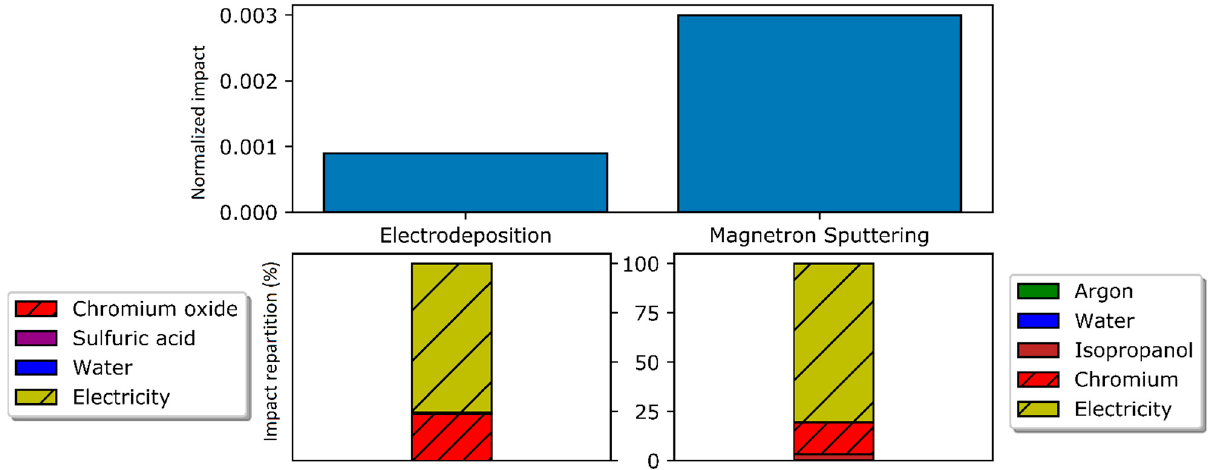
Figure 4. Top : Normalized GWP for electrodeposition and magnetron sputtering. Bottom left : Impact distribution for magnetron sputtering sub-processes. Bottom right : Impact distribution for electrodeposition sub-processes.